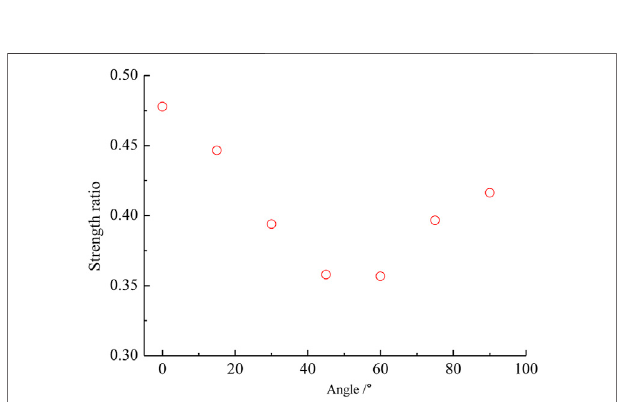
FIGURE 6 | Ratio of loads of disk samples with different inclination angles to intact samples.